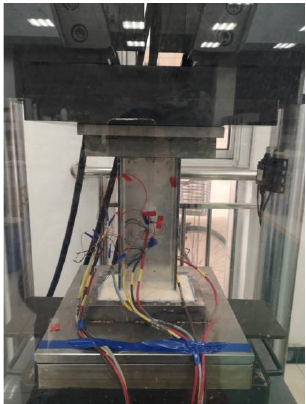
Figure 6: Schematic of the axial compression test setup for CARALL specimens.